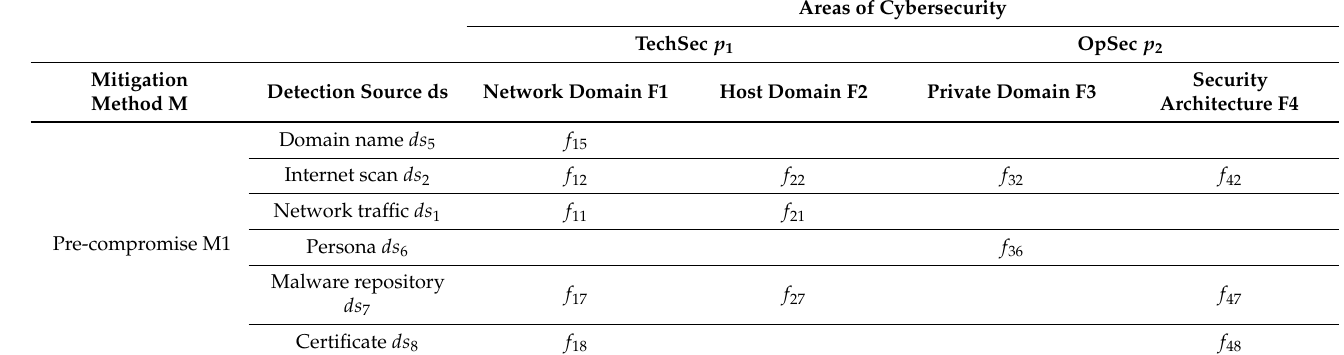
Table 2. Stage 2: Weaponization.